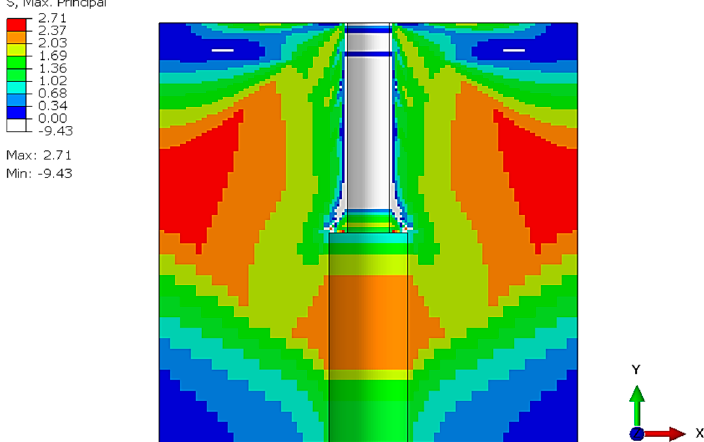
Figure 22. Map of maximum principal stresses for POT-16 series for modified concrete material model.